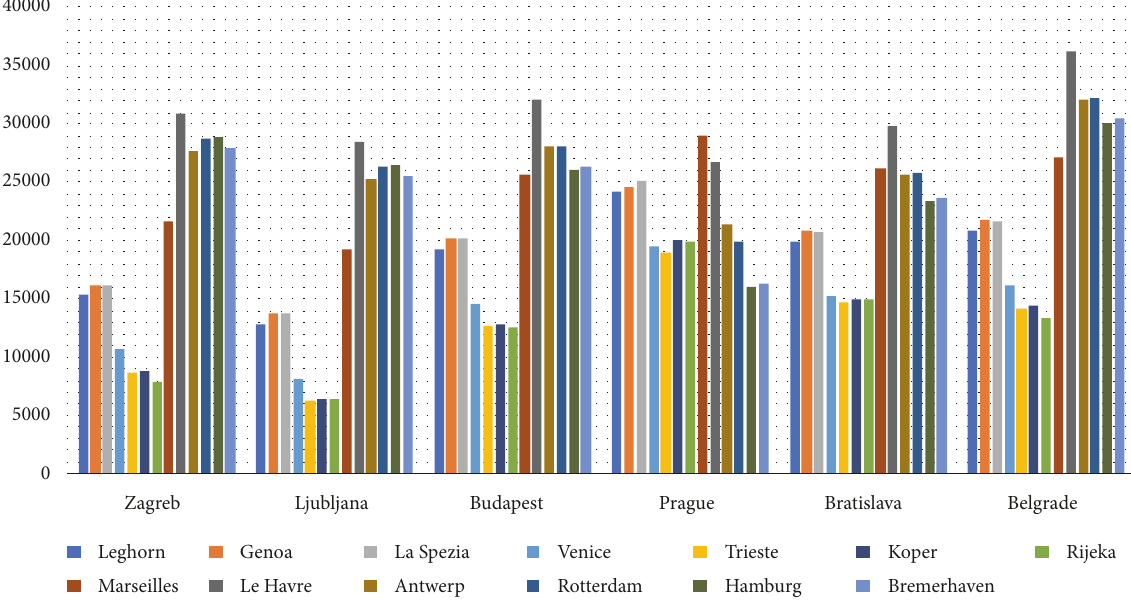
Figure 10: Monetary costs for a full train (€) from the ports considered in the analysis, towards Central-Eastern European destinations. Optimisation by monetary